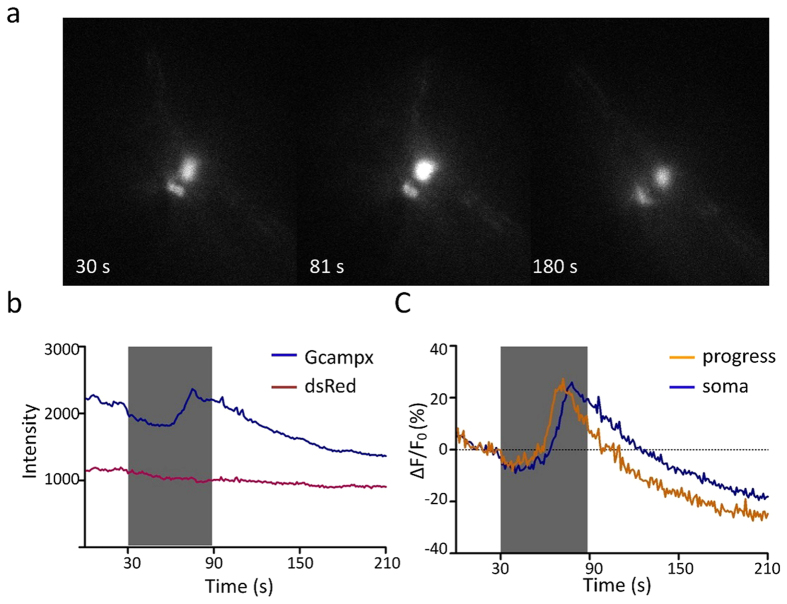
SDS induces calcium elevations in the PHA/PHB neurons.(a) Calcium transients in the PHA/PHB neurons visualized with GCaMP5.0. A red fluorescent protein DsRED was co-expressed as a reference. Individual frames taken before, during and after application of 1:100 SDS are shown. (b) Fluorescence intensities reflect an increase in the calcium intracellular level in PHA/PHB neurons. (c) Calcium transients in the cell body and dendrites of PHA/B have similar profiles in response to a 60 s stimulus of 1:100 SDS.